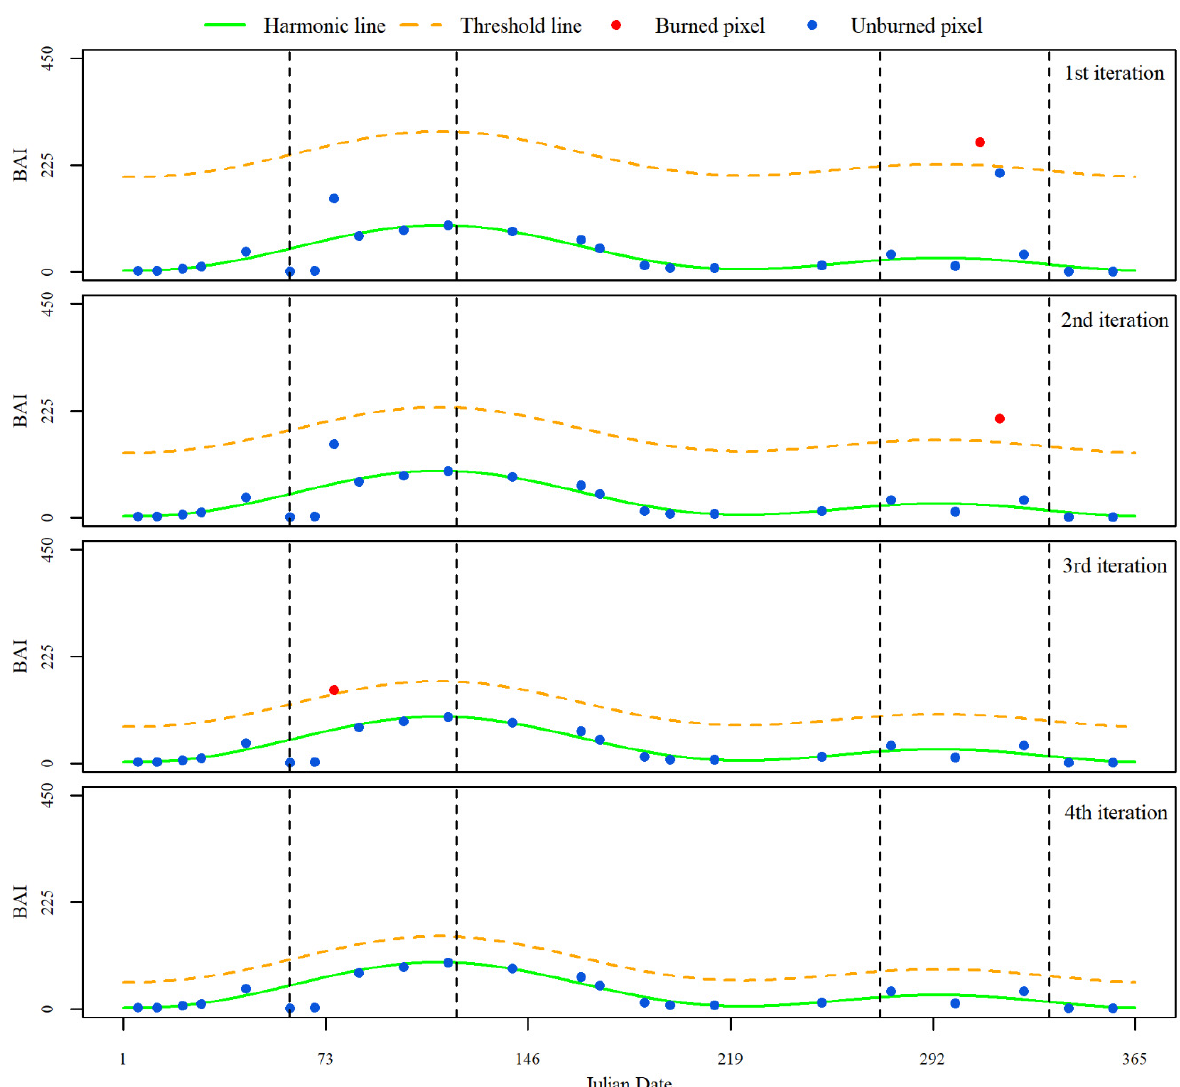
Figure 4. Demonstration of the multi-harmonic model fitting. The blue and red points represent unburned pixels and burned pixels, respectively. The green and dashed orange curves represent multi-harmonic fitting results and threshold fitting results for each regression, respectively. The vertical black dashed lines are the boundaries of fire season.